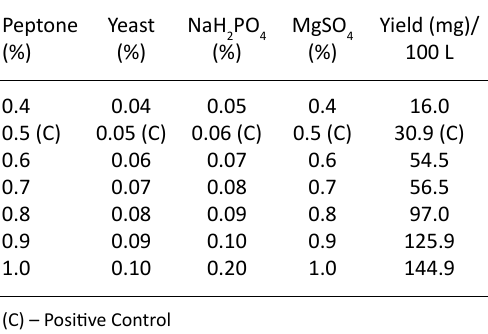
Table 1. Effect of different nutrients on the yield of